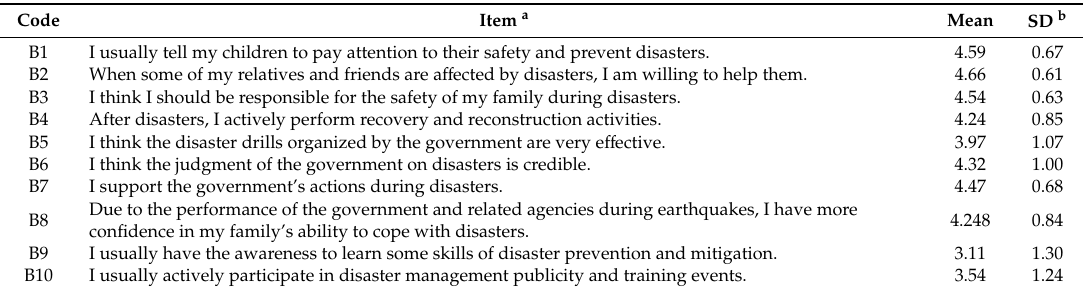
Table 2. Measurement of awareness of disaster risk reduction.